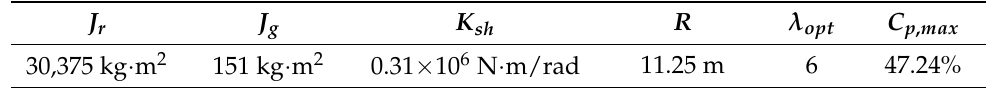
Table 1. Model parameters of a small-sized wind turbine.